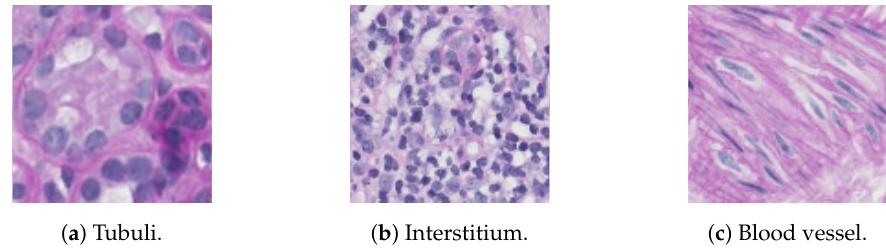
Figure 5. Color normalization by means of Reinhard’s method.